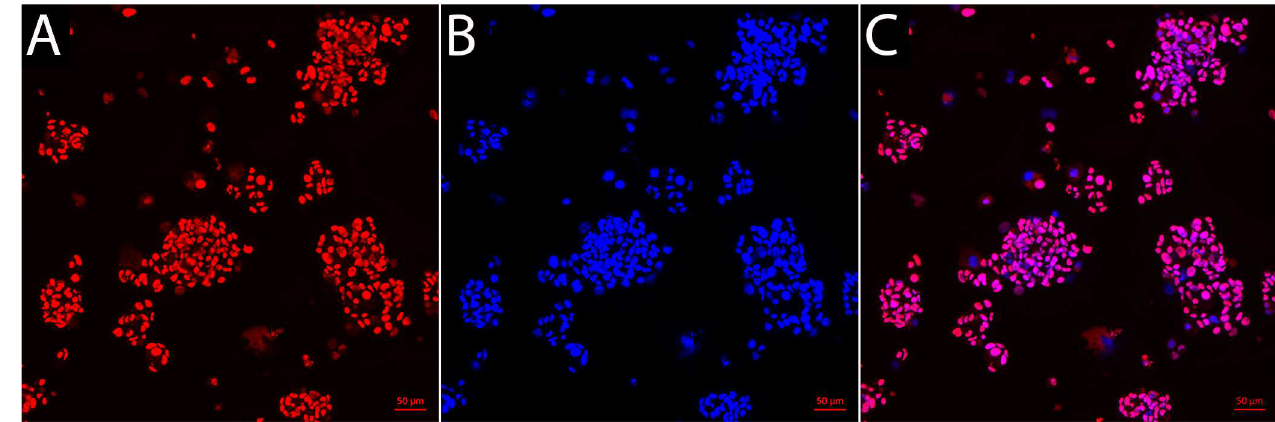
Fig 1. Human nuclear antigenimmunofluorescencestainingof the GBM1 cell line (A) with nuclear DAPI counterstain ( B) and the overlay (C)